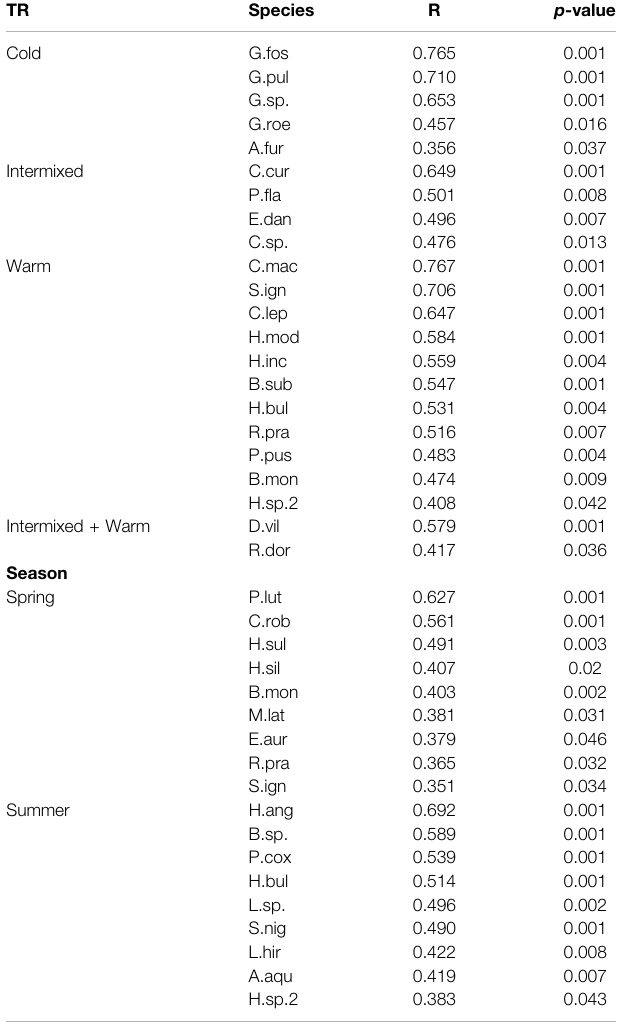
TABLE 5 | Results of multilevel pattern analysis with species of signi fi cant abundances for aspeci fi cThermal region (TR), habitat (macrophytes or gravel dominated) and season (spring or